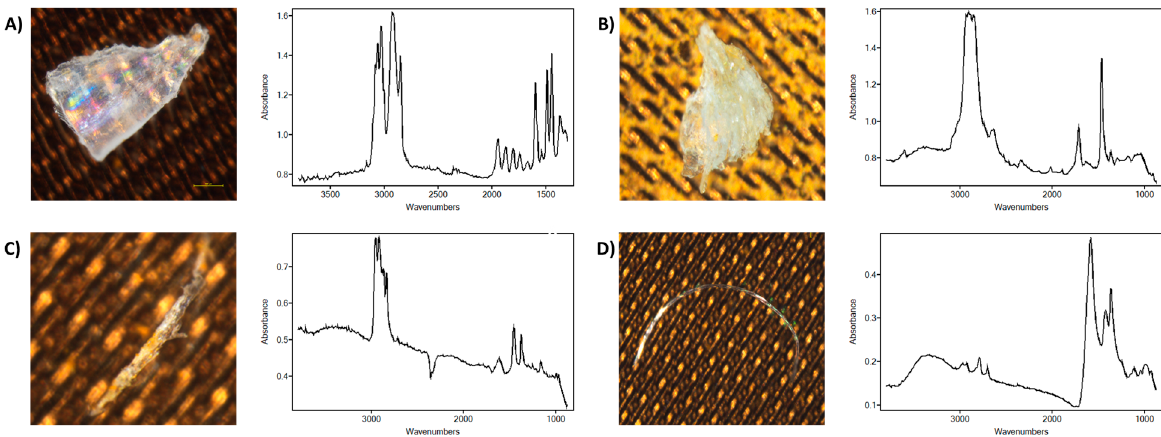
Figure 4. Verification and identification of MP-particles >100 µm by µ-FTIR. Specific µ-FTIR spectrum and corresponding photos from microscopy are shown for: ( A ) a transparent fragment (~600 µm) from site 8 identified as PS; ( B ) a transparent fragment (~400 µm) from site 15 as PP; ( C ) a transparent fiber (~450 µm) from site 7 identified as PP; ( D ) a transparent fiber (~1500 µm) from site 16 identified as PET.